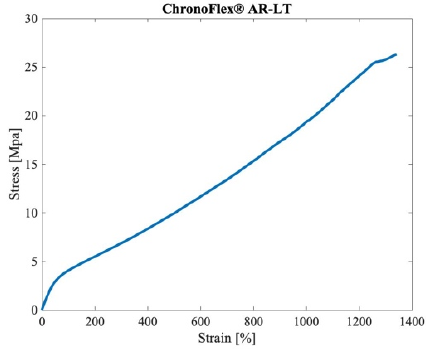
Figure 8. Engineering curve of the ChronoFlex ® AR-LT, as obtained by the uniaxial tensile tests.